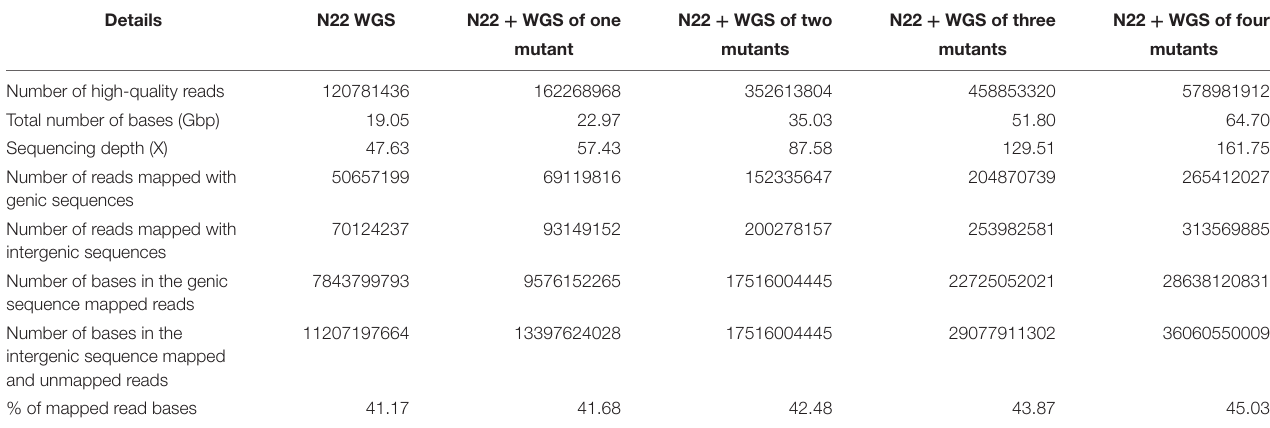
FIGURE 5 | Descriptive statistics and distribution of organic (chlorophyll and wax content) and inorganic constituents (P, Si, and Cl) in the rice EMS mutant garden of Nagina 22. (A) Total chlorophyll; (B) Epicuticular wax; (C) Phosphorous; (D) Silicon; (E) Chlorine. Units of the traits measured are indicated in the parenthesis. The number of mutants (N) used for each trait assessment is indicated. TABLE 2 | Summary of Nagina 22 whole genome sequencing (WGS) and genic sequence